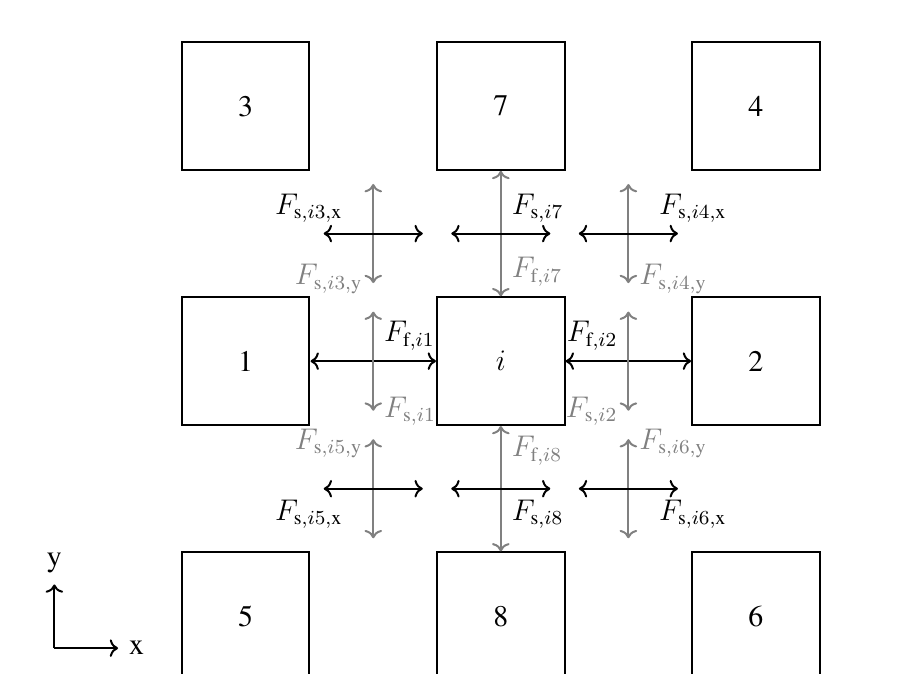
Figure 2: Coupling forces of the i th fuel assembly with its neighbors j i = 1 , 2 , . . . , 8